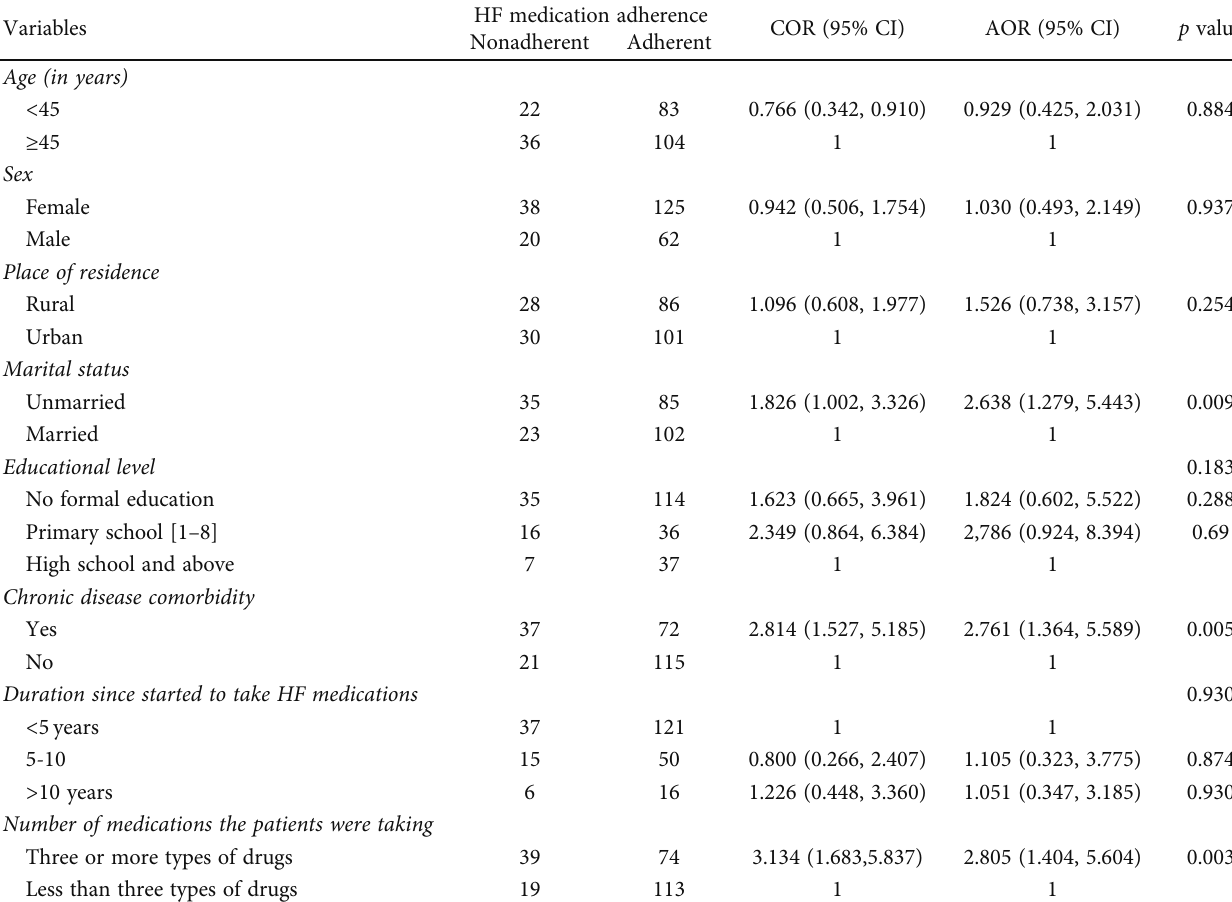
Table 3: Binary logistic regression analysis of factors associated with medication nonadherence among HF patients at University of Gondar Comprehensive Specialized Hospital, northwest